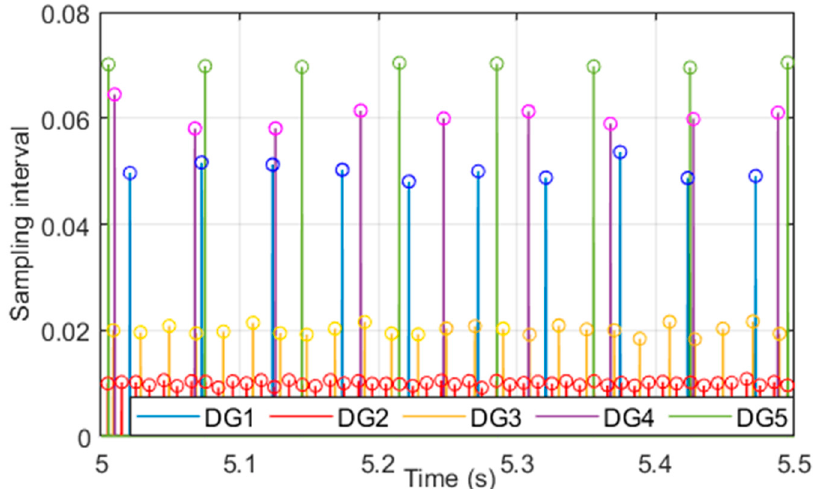
Figure 8. Arbitrary sampling intervals assuming uncertainties within ±10% T i on the basis of indi-